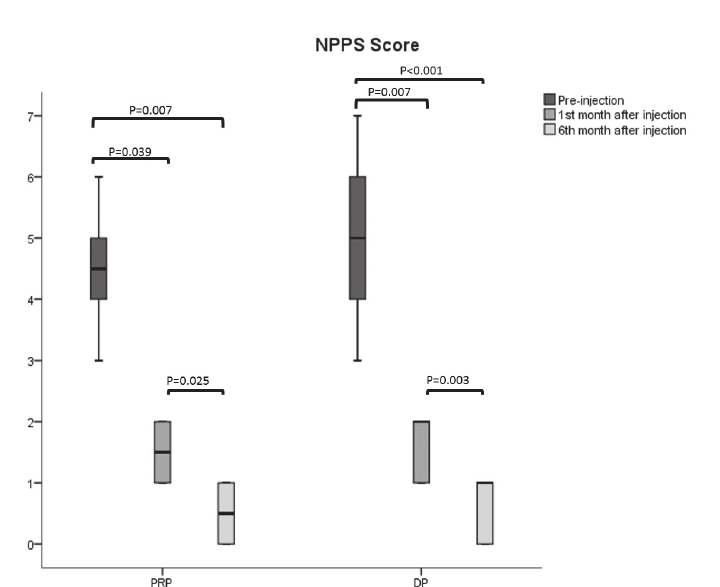
FIGURE 2. The box plots showing the initial and follow-up Nirschl Pain Phase Scale (NPPS) scores of dextrose prolotherapy (DP) and platelet-rich plasma (PRP)